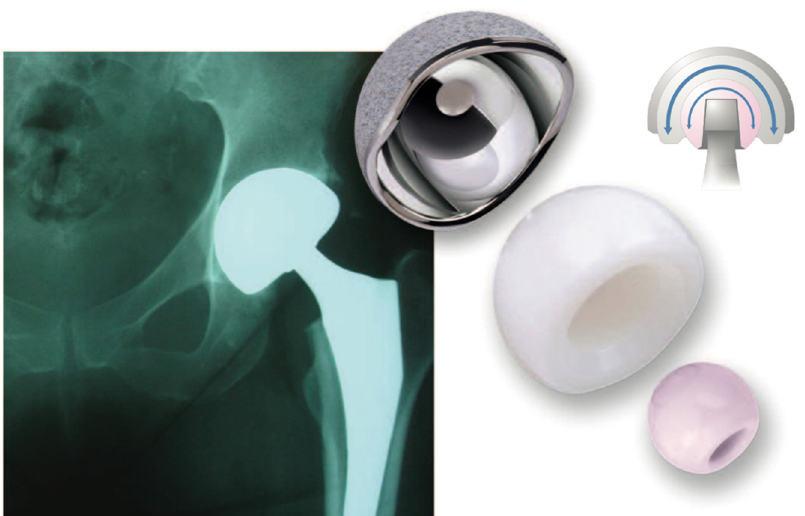
Figure 3. Composite image showing a monobloc DM acetabular component and its two main articulations: large polyethylene ball articulating with the metallic cup and the smaller articulation between the 28 mm ceramic head and the polyethene head (mobile liner).